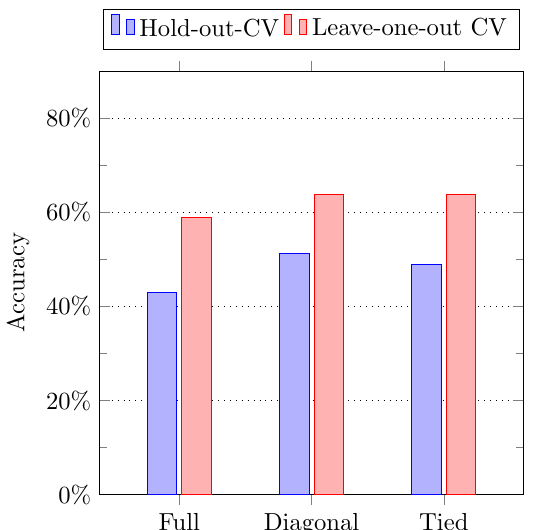
Figure 9. The composite activity recognition accuracies using Hidden Markov Model (HMM)